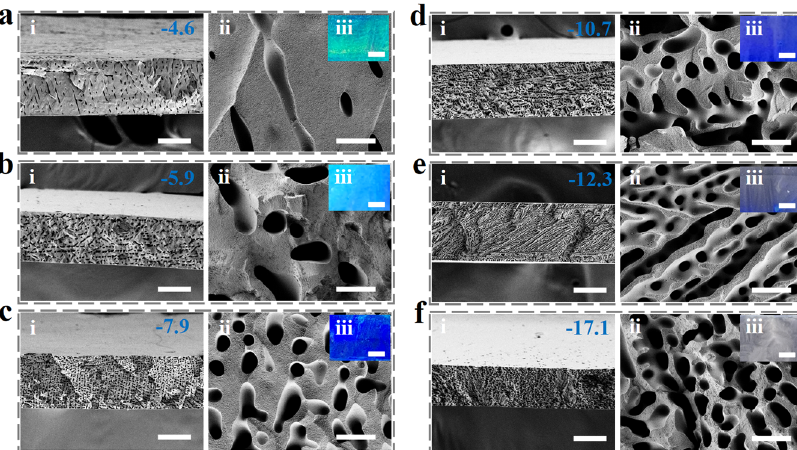
Fig. 5 Comparison of ice-templated structural color hydrogels under different freezing temperatures. The temperatures are − 4.6 °C in ( a ), − 5.9 °C in ( b ), − 7.9 °C in ( c ), − 10.7 °C in ( d ), − 12.3 °C in ( e ), and − 17.1 °C in ( f ). The v/v ratio of H 2 O/PEGDA was 1:1. Nanoparticles with a diameter of 145 nm were employed. Scale bars are 100 μ m in (i), 10 μ m in (ii), 2 mm in (iii).